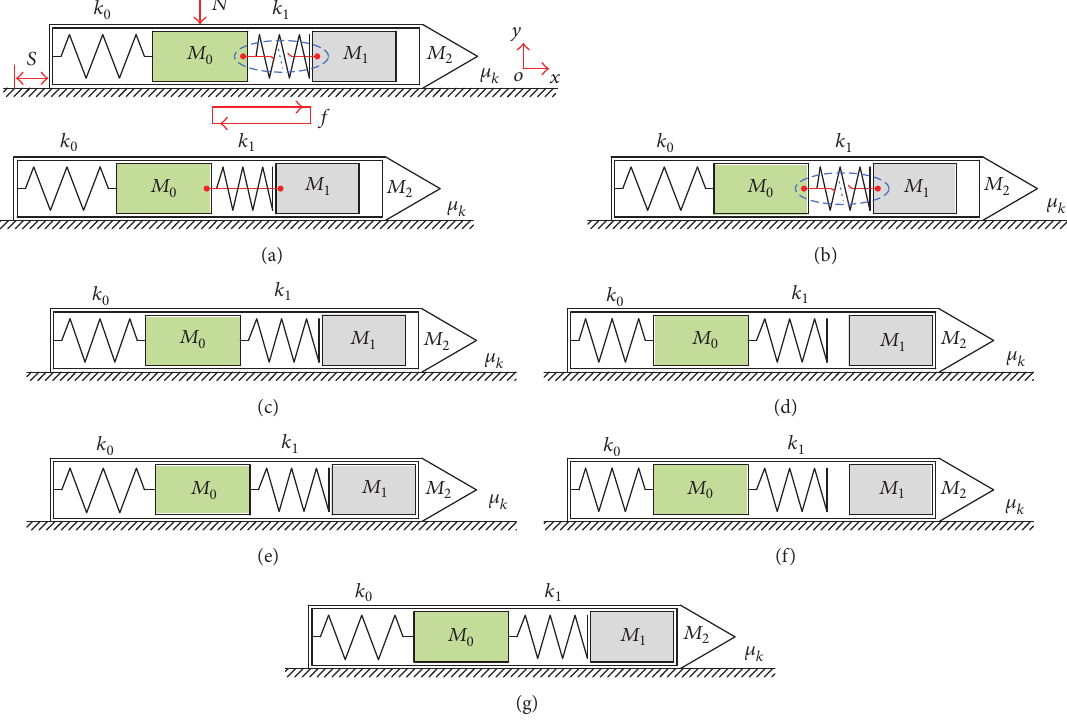
Figure 2: Dynamic model of the